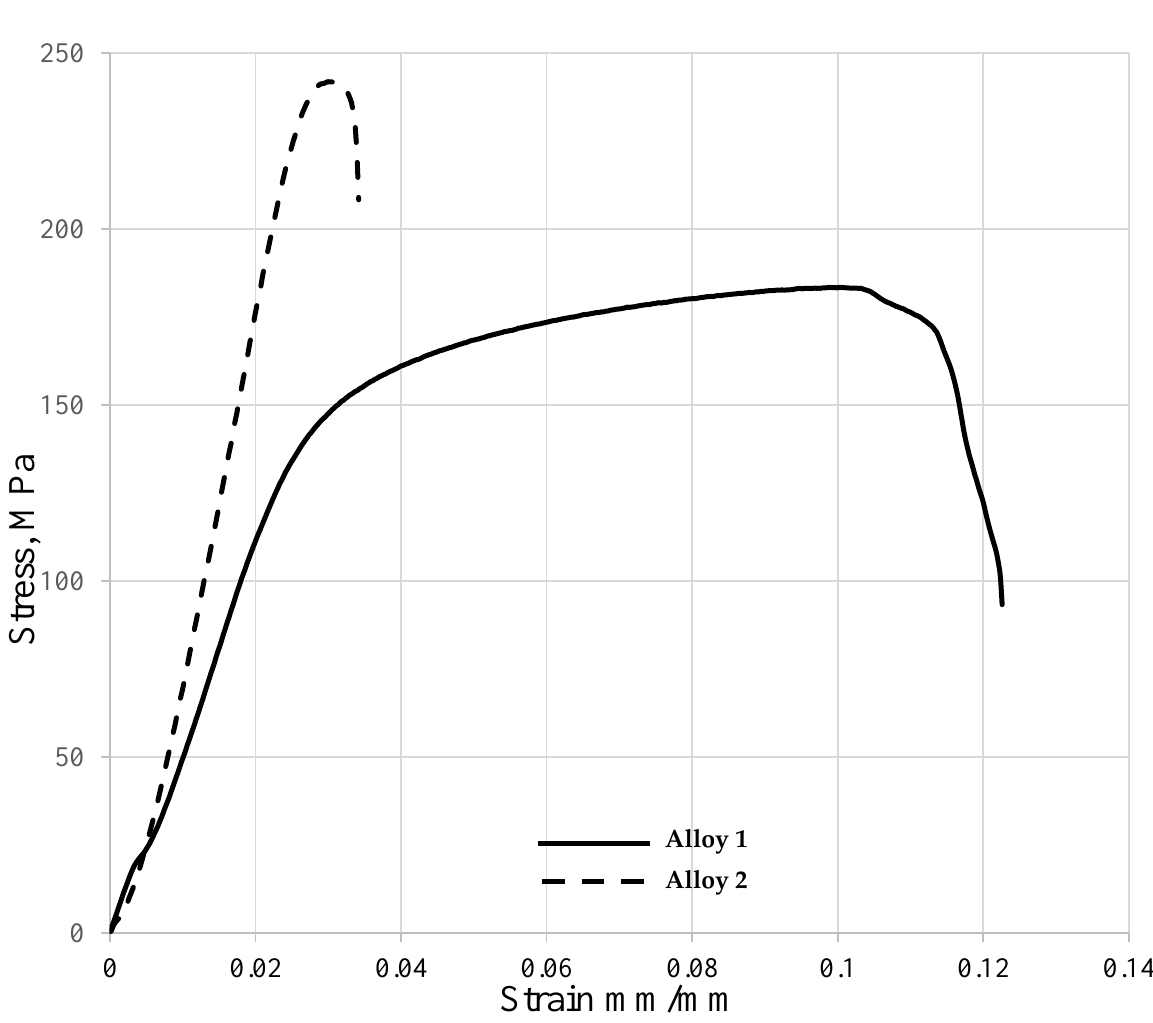
Figure 9. Engineering stress vs. strain curves of the peak-age-treated (PA) Al-Cu-Mg-Ag alloys at 180 ◦ C. Table 2. Comparison showing the difference of mechanical properties with respect to the testing environment. Mechanical Properties/Environment Alloy